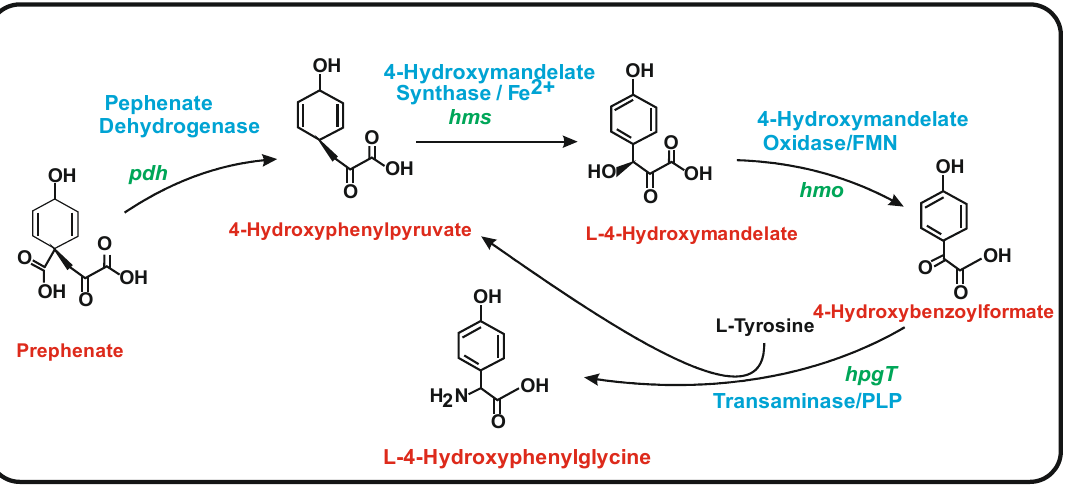
Figure 7. Biosynthesis of L-4-hydroxyphenylglycine. The substrate, intermediates and final product of the reaction are indicated (red colour). The enzymes involved are indicated in blue colour. The encoding genes in Amycolatopsis orientalis are indicated in green color. Note that the 4-hydroxy- phenylpyruvate formed from the tyrosine amino donor is recycled as an intermediate of the path- way.